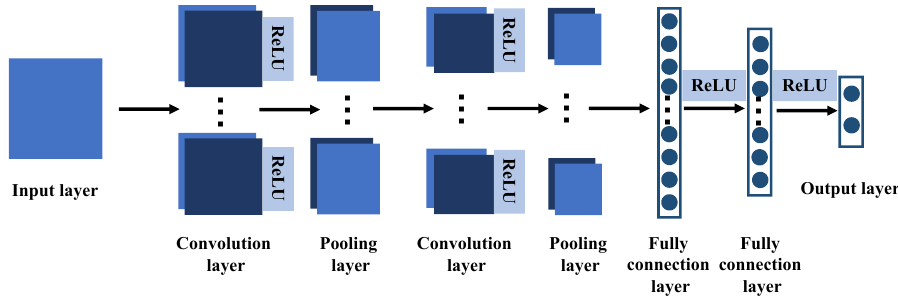
Figure 9. The network structure of